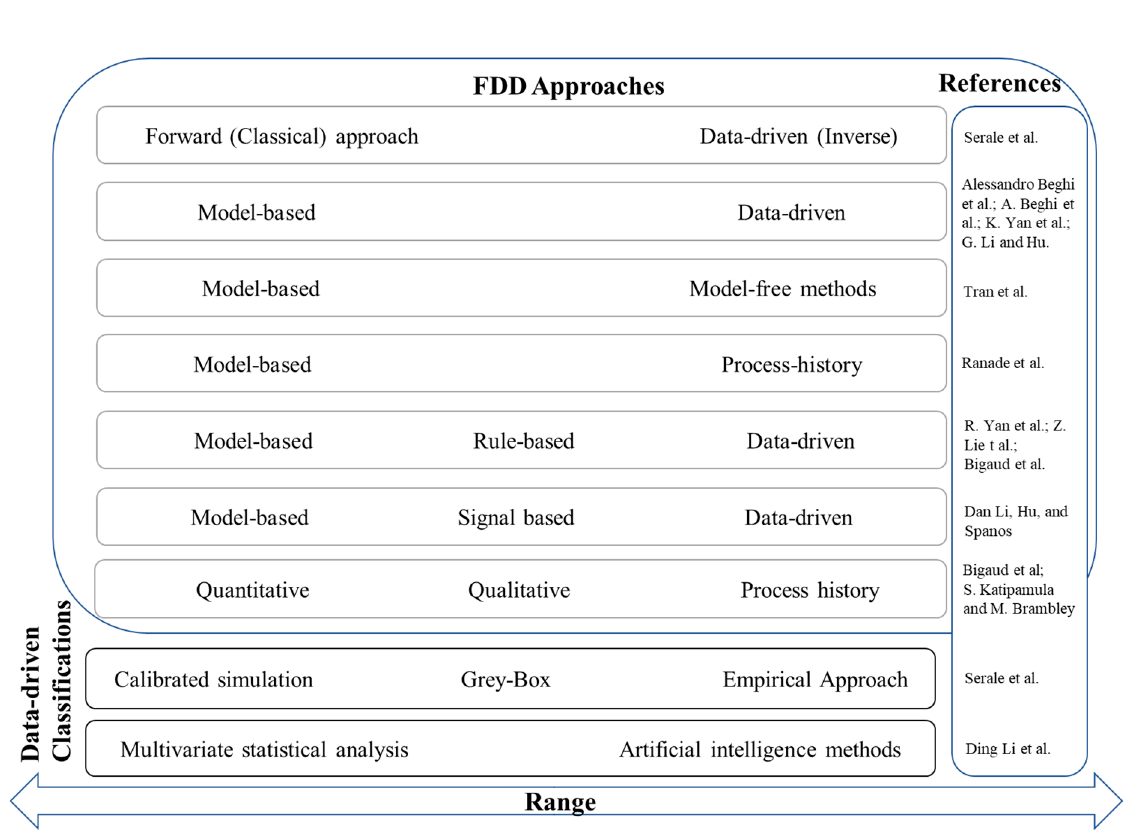
Figure 1. Holistic FDD and data-driven modeling approaches. One classification for AFDD methods is the top-down versus bottom-up approach. level, whereas the bottom-up approach focuses on the component or sub-system level. In both approaches, models of ideal operation conditions are compared with actual meas-